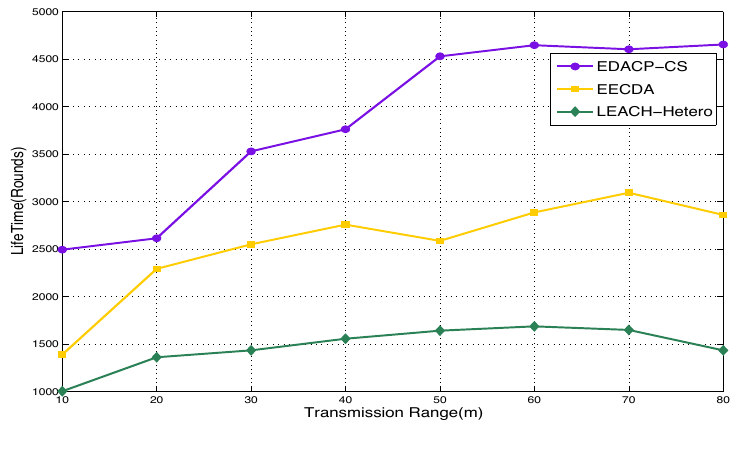
Figure 9. Transmission range vs . lifetime.